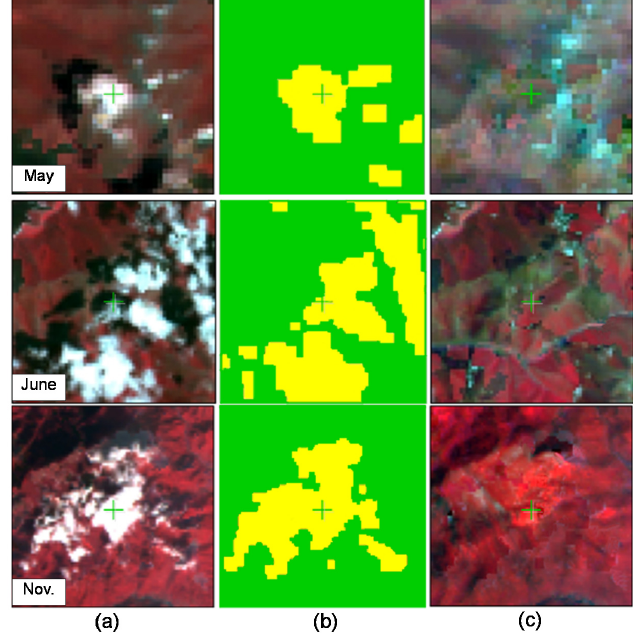
Figure 4. Comparison of residual clouds in the monthly composited images and their Savizky–Golay filter reconstruction results of May, June and November: ( a ) the residual clouds in the monthly composites; and ( b ) the residual clouds mask generated by the median value method, where the yellow color is clouds and green color is background. The identified clouds are a little larger in extent because of three pixel dilation of clouds to exclude some thin edges of clouds; ( c ) The reconstruction results by the Savizky–Golay filter.